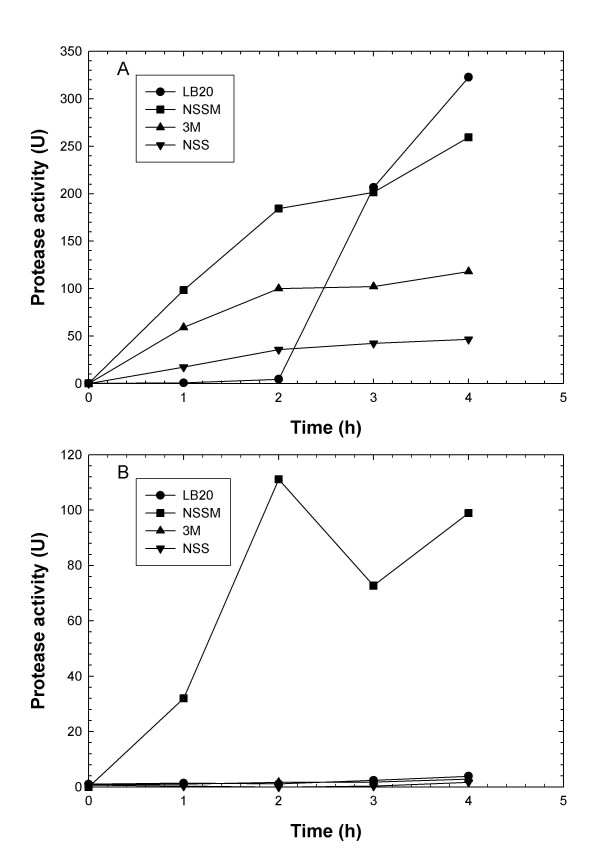
Induction of protease activity in V. anguillarum NB10 (A) and M93Sm (B) cells incubated in LB20 (●), NSSM (■), 3M (▲) or NSS (▼). Cells were grown for 16 h in LB20 at 27°C, harvested by centrifugation, washed twice in NSS, and resuspended at 2 × 109 CFU/ml in each condition. Samples were taken at the indicated times and cell-free supernatant was tested for protease activity using the azocasein assay. Both of the experiments shown represent a single experiment, although each experiment was repeated at least three times with similar results.